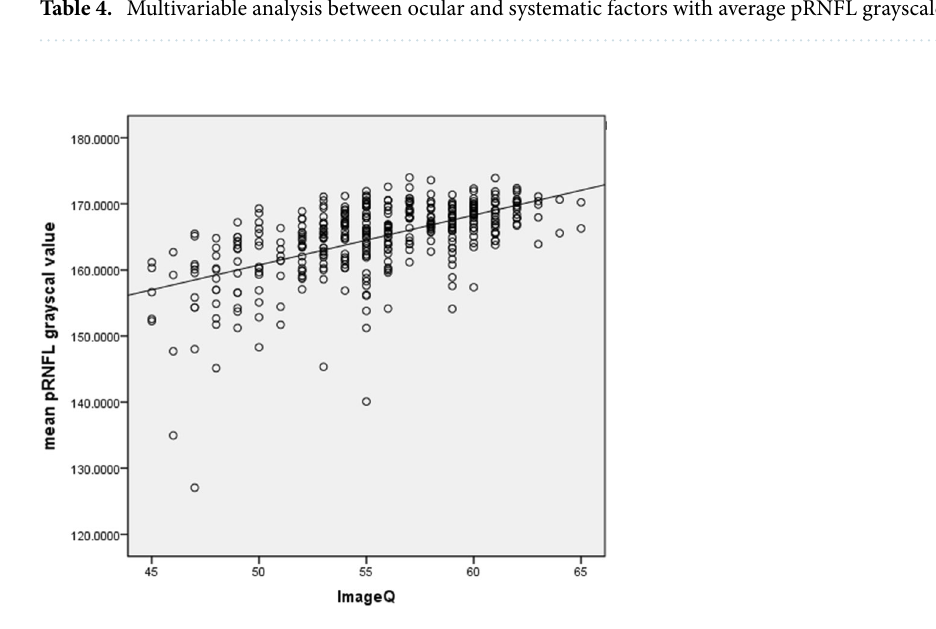
Figure 6. Scatterplot of mean pRNFL grayscale value against ImageQ.